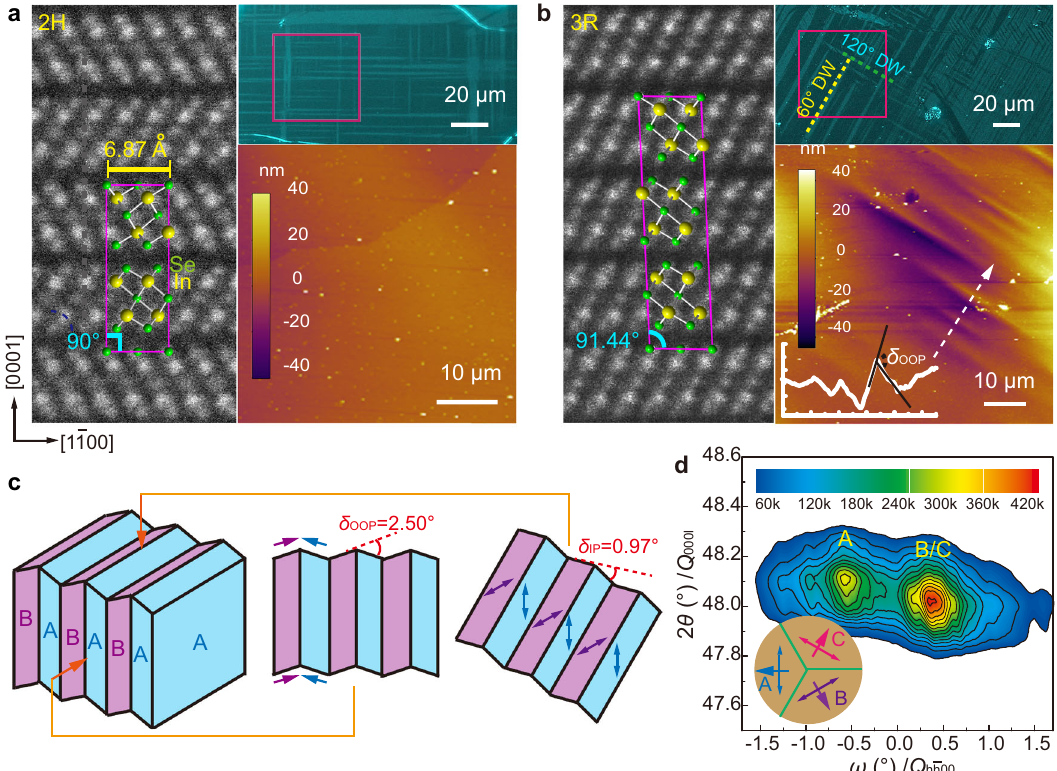
Fig. 6 Surface wrinkles across 120° DWs owing to the 3D stacking in 3R β ’ -In 2 Se 3 . a , b Atomic-resolution cross-sectional STEM images with the structure models overlaid, and polarized-light images showing multidomain patterns, with AFM topographic images taken from the highlighted regions, for 2H ( a ) and 3R ( b ) β ’ -In 2 Se 3 crystals. 3R β ’ -In 2 Se 3 displays a majority of 60° DWs and minor 120° DWs, with surfaces wrinkles across 120° DWs as revealed by the surface pro fi le in the lower-left inset. In contrast, 60° DWs in the same region have the fl at surface. c Schematic drawing of the 120° domain pattern in 3R β ’ -In 2 Se 3 , showing surface wrinkles across 120° DWs with a 2.50° out-of-plane (OOP) mosaic tilt. The associated in-plane (IP) tilt is ~0.97° (see Supplementary Fig. 8). The IP strain is indicated by double-headed arrows and the shear strain by single-headed arrows. d Reciprocal space map with 2 θ / ω scan around (0 0 0 15) re fl ections. The two re fl ections indicate the OOP mosaic tilt due to the shear strain illustrated in c . The directions of the shear strain with respect to the IP strain are indicated in the lower left inset by single-headed arrows.